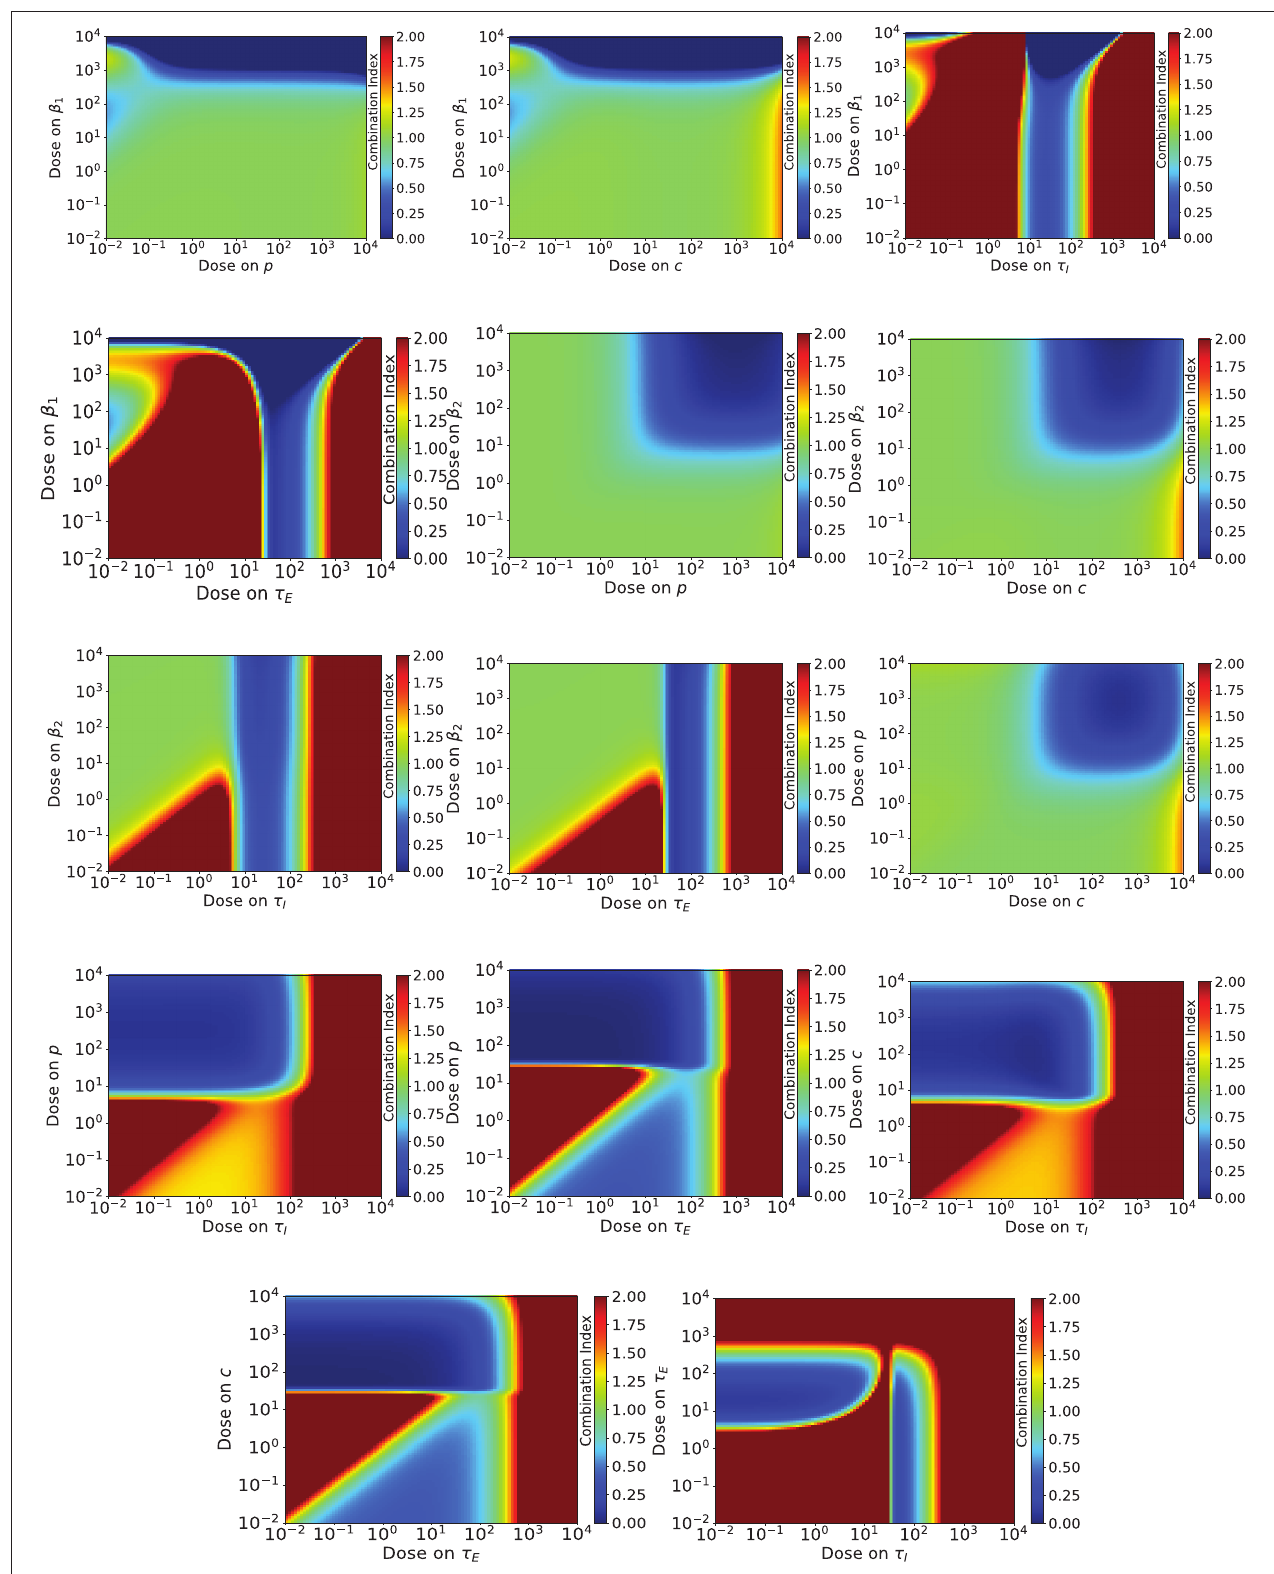
FIGURE 5 | Combination index for a range of doses of various combinations of influenza antivirals. Antagony of the antivirals is indicated by regions of blue, while regions of synergy are indicated by red. A combination index of one (no effect) is pale green.